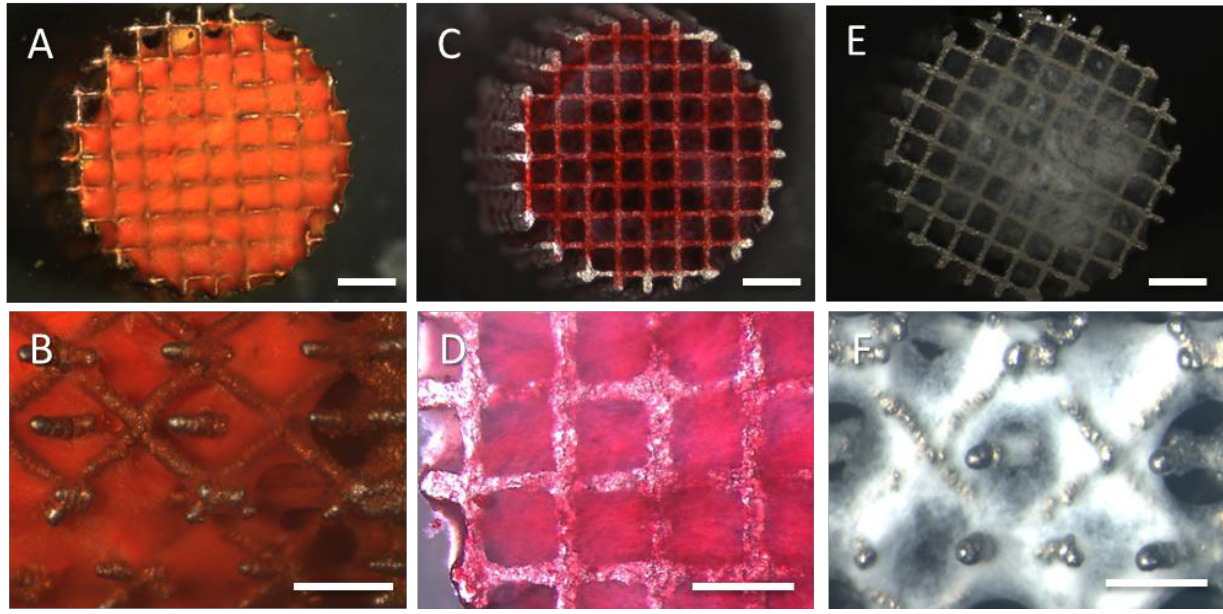
Figure 5. Representative images for the midpoint experimental time point (B3) showing collagen matrix content by positive Picrosirius Red staining ( A , B ) and mineral content by positive Alizarin Red staining ( C , D ), but also as evidenced by bright field images ( E , F ). Scale bar: 1